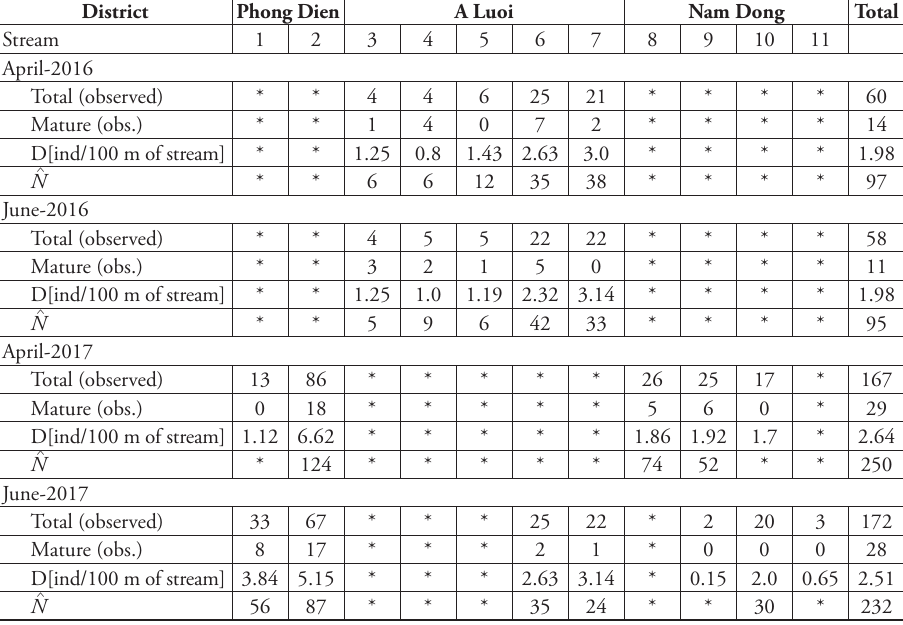
Table 2. Summary of observed individuals as well as densities and population size estimates ( N ^ ) of Physignathus cocincinus in Thua Thien Hue Province, central Vietnam in April and June, 2016 and 2017. D: Density; ind: individuals; Asterisks indicate missing